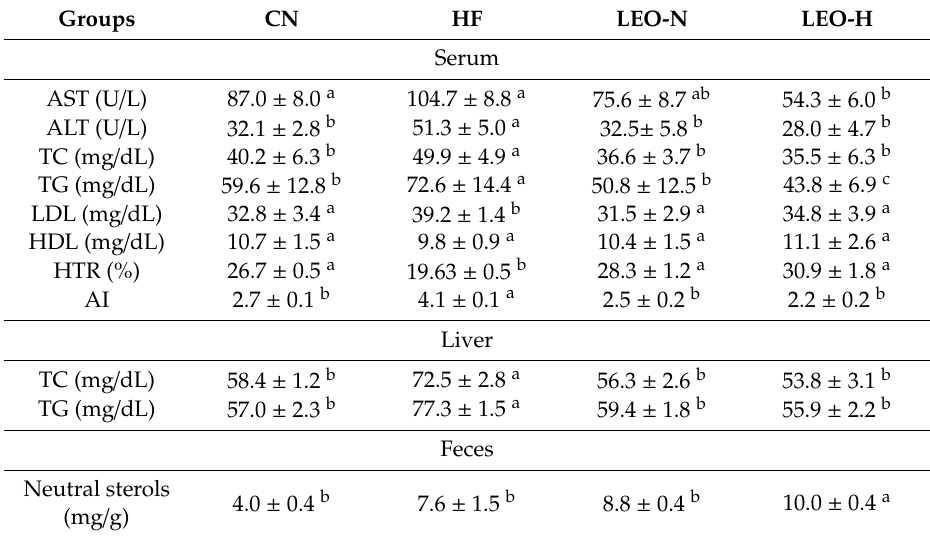
All values are mean ± SD, and the values in a column not sharing a common superscript letter are significantly different from one another according to Duncan’s range test ( p < 0.05) ( n = 8). HTR = (HDL-Cholesterol/total Cholesterol) × 100; AI, atherogenic index = (total Cholesterol—HDL-